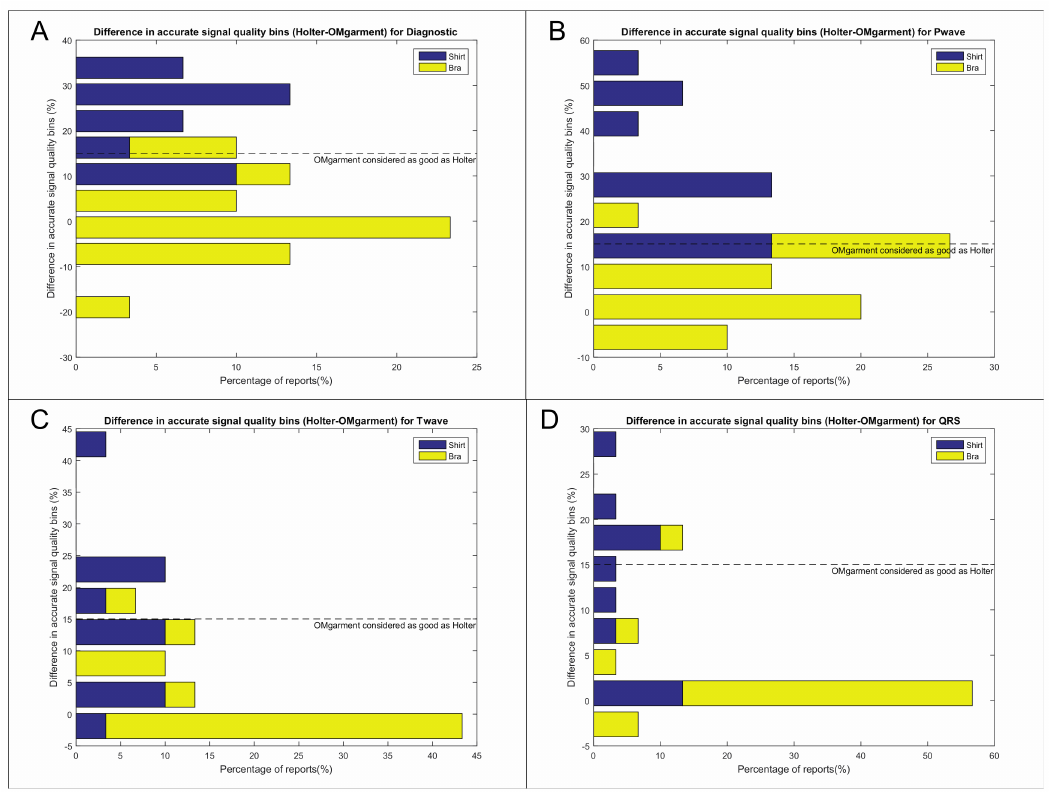
Figure 5. Accuracy of signal morphology by semi-quantitative assessment. Shown are histograms of a Kolmogorov distribution derived from the combined score ranking of the averaged semi-quantitative assessment of the overall morphology accuracy of ECG signals recorded by Holter and the OMgarments. Each histogram displays the proportion and degree of diagnostic bins of recordings with the OMgarments compared to Holter regarding the overall accuracy ( A ) and signal quality of P, QRS, and T ( B – D ). Diagnostic bins are presented as stacked columns containing the data for males (OMshirt) and females (OMbra). All diagnostic bins below the prespecified noninferiority margin of 15% indicate that the signal quality of the OMgarment was as good as the Holter recording. (A) The overall signal accuracy was noninferior to the Holter recording, but the results were largely driven by recordings in females. Overall signal quality in males was inferior to Holter recording in up to 75% of recordings, mostly related to high levels of noise (please see Section 3.5) and inferior P-wave quality ( B ). Signal quality of QRS complexes ( C ) and T-waves ( D ) were also significantly better in females compared to